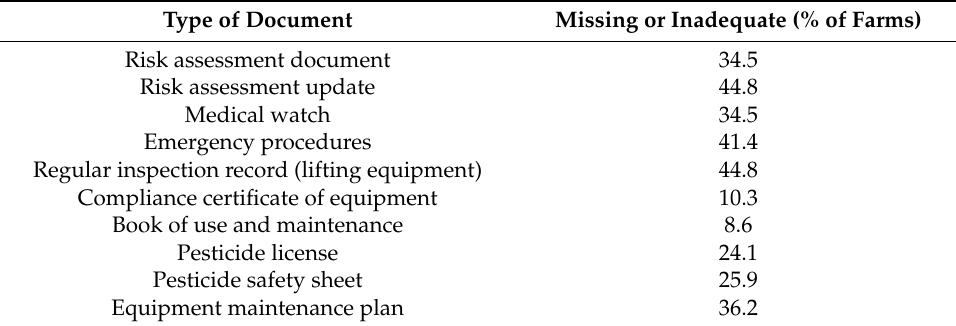
Table 2. Official documents at the farm.